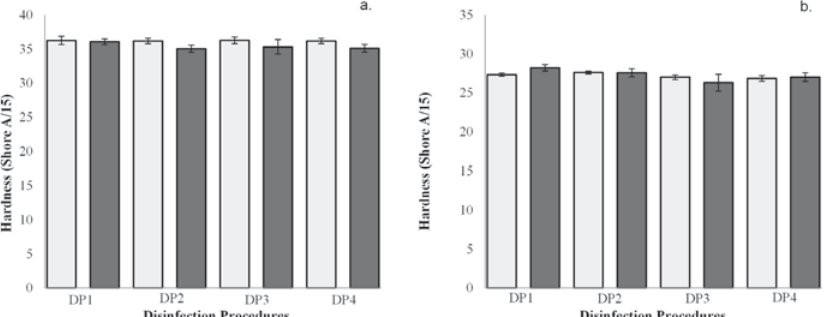
Figure 4- Mean values of hardness measurements and standard deviation before (grey columns) and after (black columns) each disinfection procedure for material a. A and b.